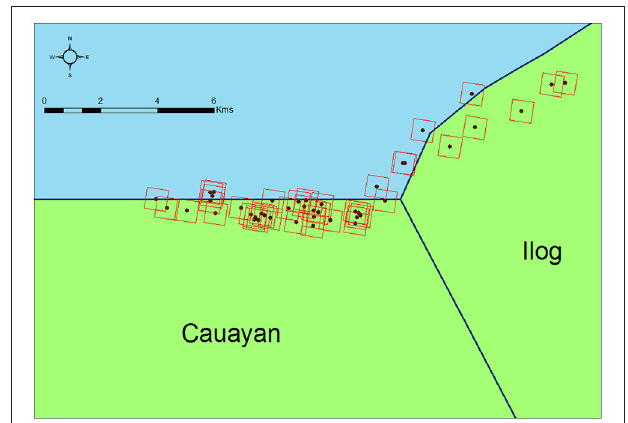
FIGURE 10 | Footprints of VBD pixels plotting along the outer closure boundaries for the Cauayan and Ilog municipal waters from August 2017. Because the light source detected by VIIRS can be located anywhere inside the pixel footprint, those pixels that straddle the boundary line are ambiguous in terms of encroachment. Most of the detections are clearly inside the closure boundary, indicating the presence of closure